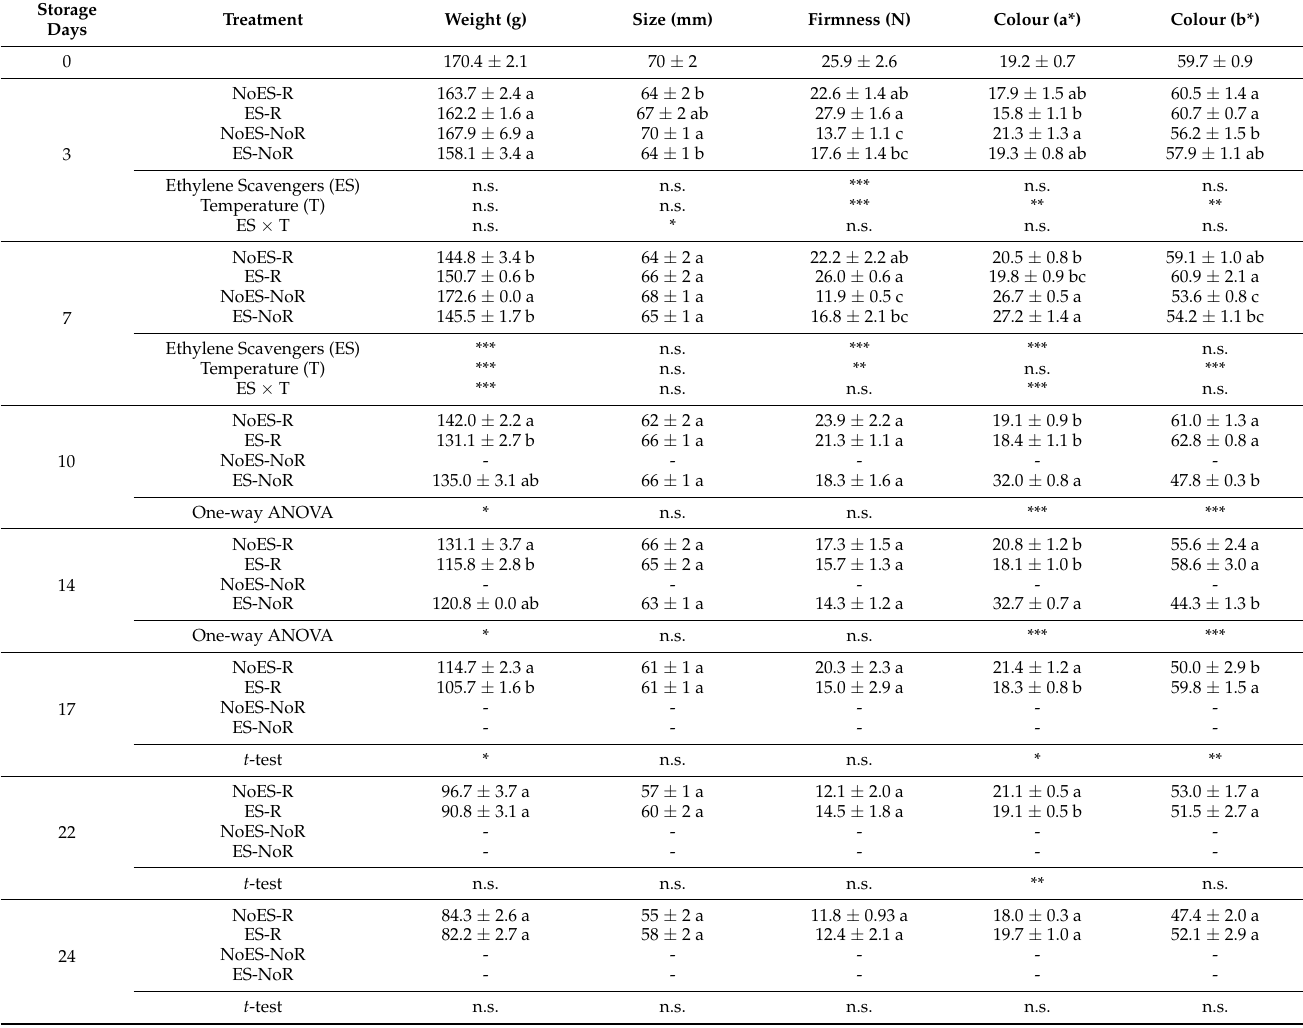
Table 1. Evolution during storage time of the physical parameters in peaches subjected to the different treatments (NoES-R, ES-R, NoES-NoR and ES-NoR). The parameters measured were weight expressed in grams; size expressed in millimetres; firmness measured in newtons; and two-colour parameters a* and b*. The mean ± standard error of the means (SEM) is shown. Different letters for each treatment represent statistically significant differences according to Tukey’s test.